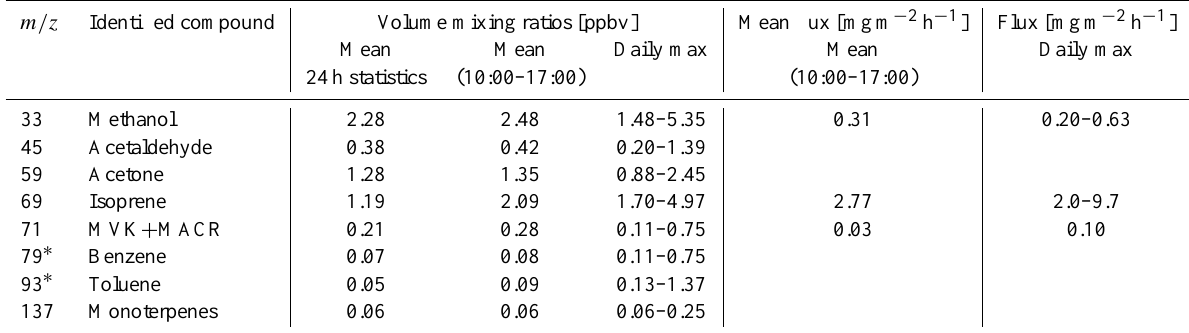
Figure 2. (left) Satellite photo of the Observatoire of Haute Provence. The red star represents the location of the measurements.Wind rose: wind direction origins (%) from 4 until 17 June 2012. (right) Location of the O 3 HP in the southeast of France. 24h duration backward trajectories ending at 00:00UTC 13 June 2012 (NOAA HYSPLIT MODEL). Table 2. Statistical summary of volume mixing ratios (ppbv) and fluxes of 12 targeted VOC above the canopy (10m) of the Oak Observatory of the Observatoire de Haute